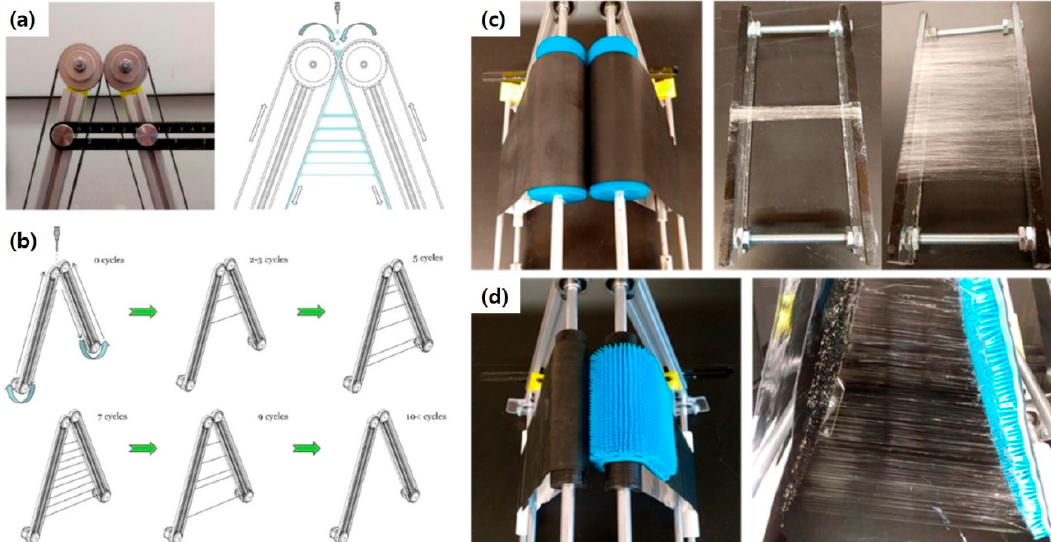
Figure 7. ( a ) The setup for track spinning, ( b ) schematic illustration of continuous fiber formation, ( c ) photographs of track spinning process with 8 cm wide tracks and of resulting aligned fibers, and ( d ) photograph of a 3D spinning system with a patterned array of bristles on one track towards precise location of fibers. [Adapted with permission from 65. Copyright (2019) American Chemical Society].